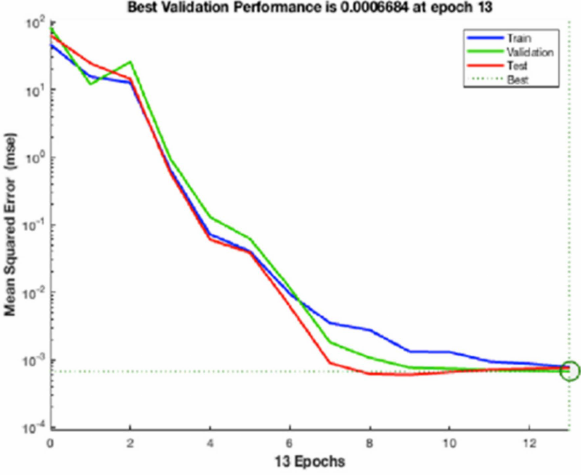
Figure 7. Performance of the training process for model two.